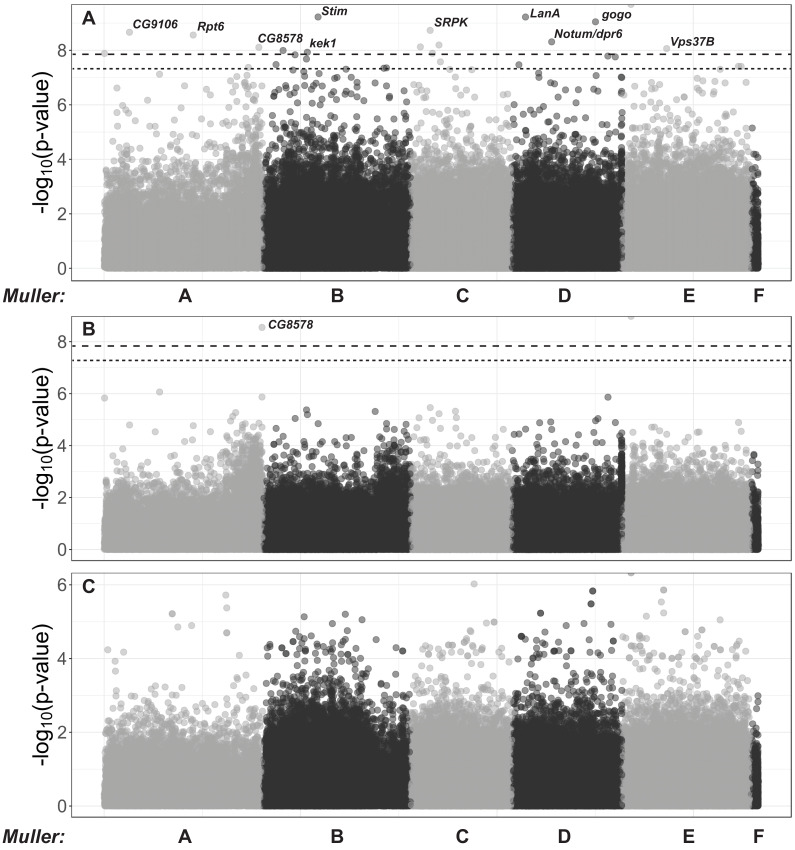
Host genome-wide association study for DiNV titer in wild D.innubila.(A) Manhattan plot of significance of SNP on viral titer after factoring in interaction with the viral haplotype. The significance cut offs are labelled (p-value<0.05 after multiple testing correction dotted, p-value<0.05 after permutations dashed). (B) Manhattan plot of SNP x viral haplotype interaction for viral titer association study in D. innubila, calculated using PLINK. The significance cut offs are labelled (p-value<0.05 after multiple testing correction dashed, p-value<0.05 after permutations dotted). (C) Manhattan plot of SNP * sex interaction for viral titer association study in D. innubila, calculated using PLINK.